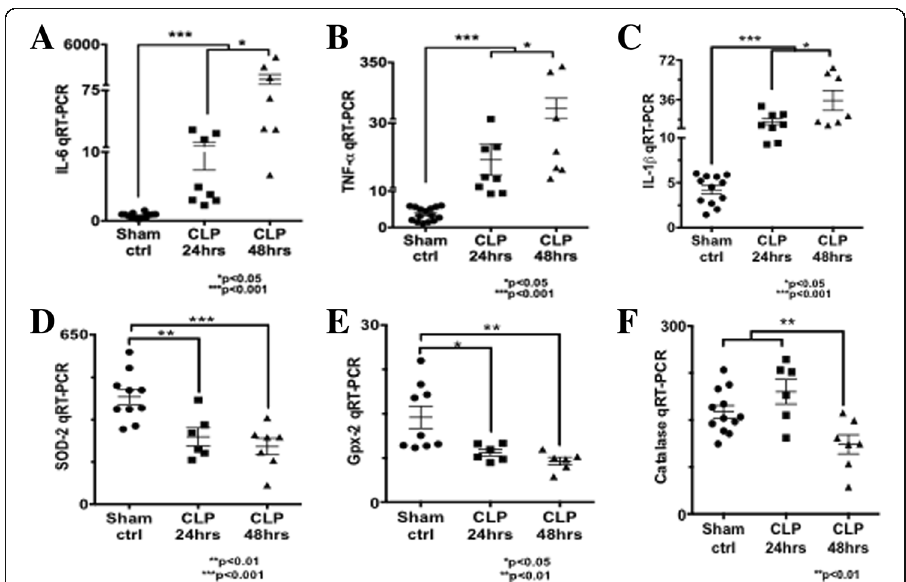
Fig. 3 Quantitative real-time PCR of pro-inflammatory cytokines (TNF- α , IL-1, and Il-6) and mitochondrial free radical scavengers (SOD-2, GPX-2, Catalase) at 24 and 48 h following CLP. Significant increase in TNF- α , IL-1, and Il-6 is seen at 24 and 48 h in the CLP group when compared to sham and control ( a – c ). Significant decrease in mitochondrial ROS scavengers is seen at 24 and 48 h post-surgery in the CLP group when compared to sham and control ( d – f